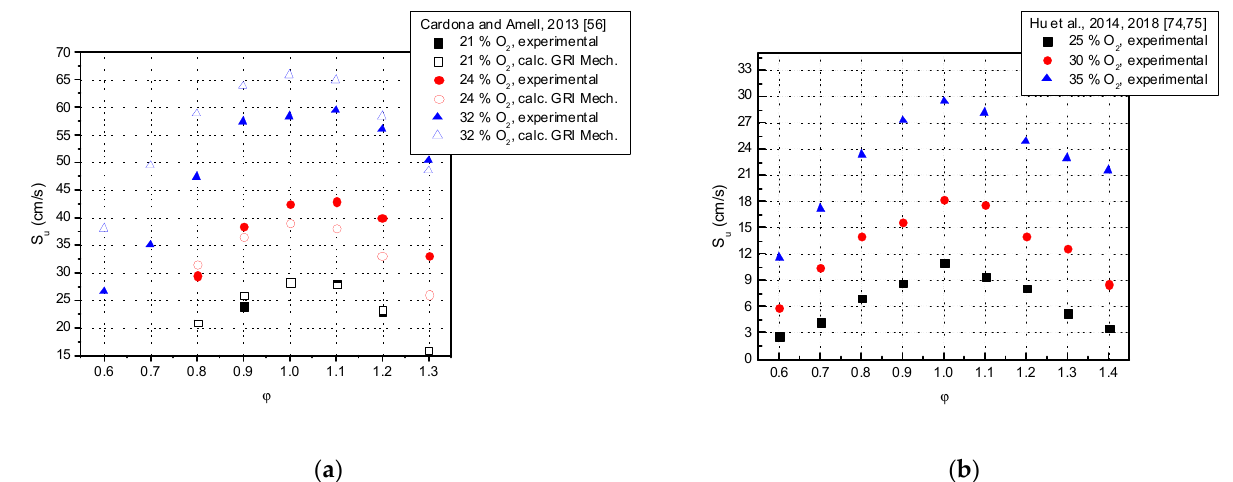
Figure 16. Laminar burning velocities of biogas mixtures enriched with oxygen. Data at: ( a ) 0.828 bar and 295 K; ( b ) 1 bar and 300 K.